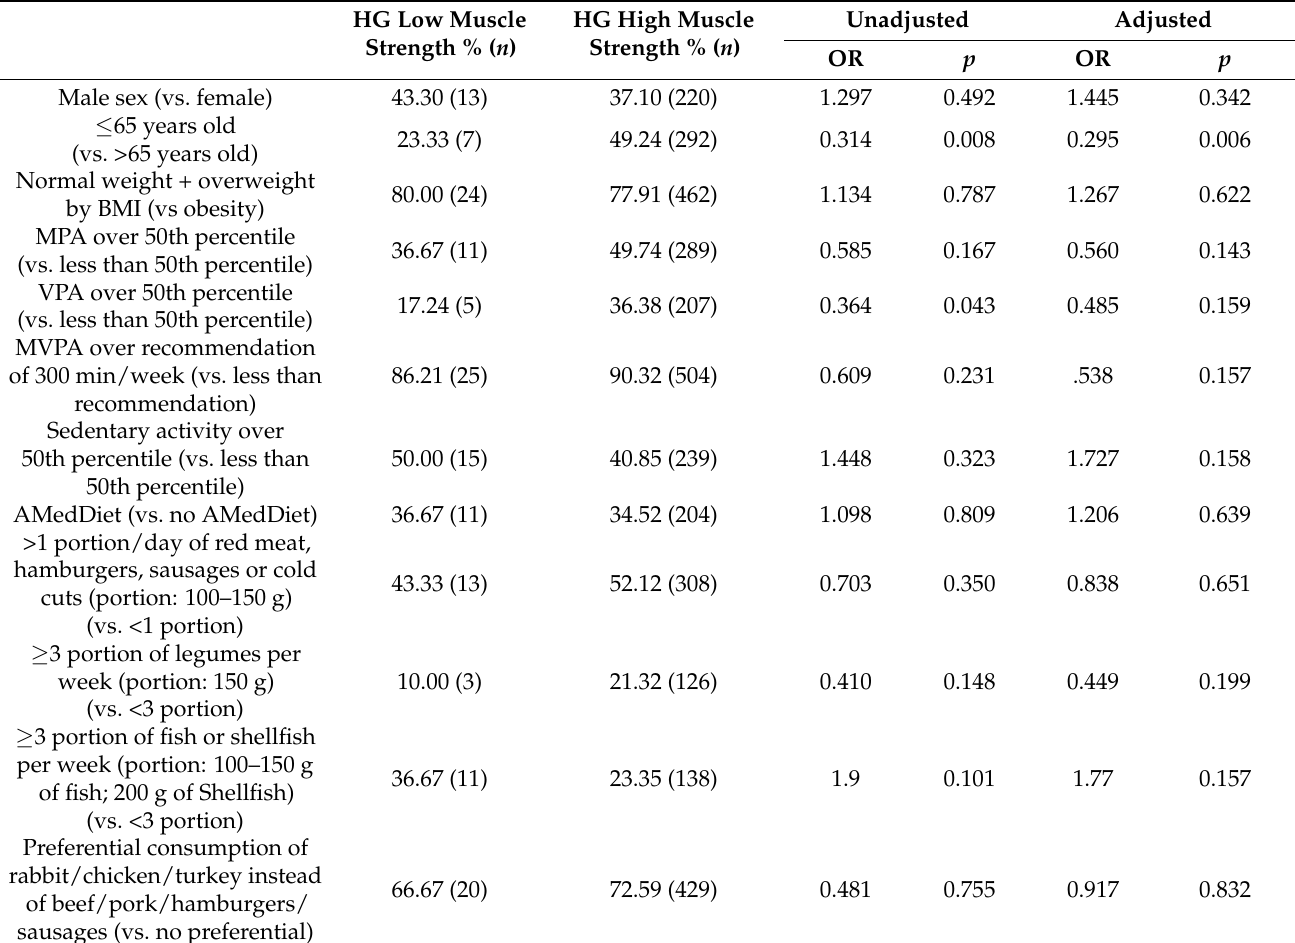
Table 3. Odds ratio of muscle strength by HG unadjusted and adjusted by sex and